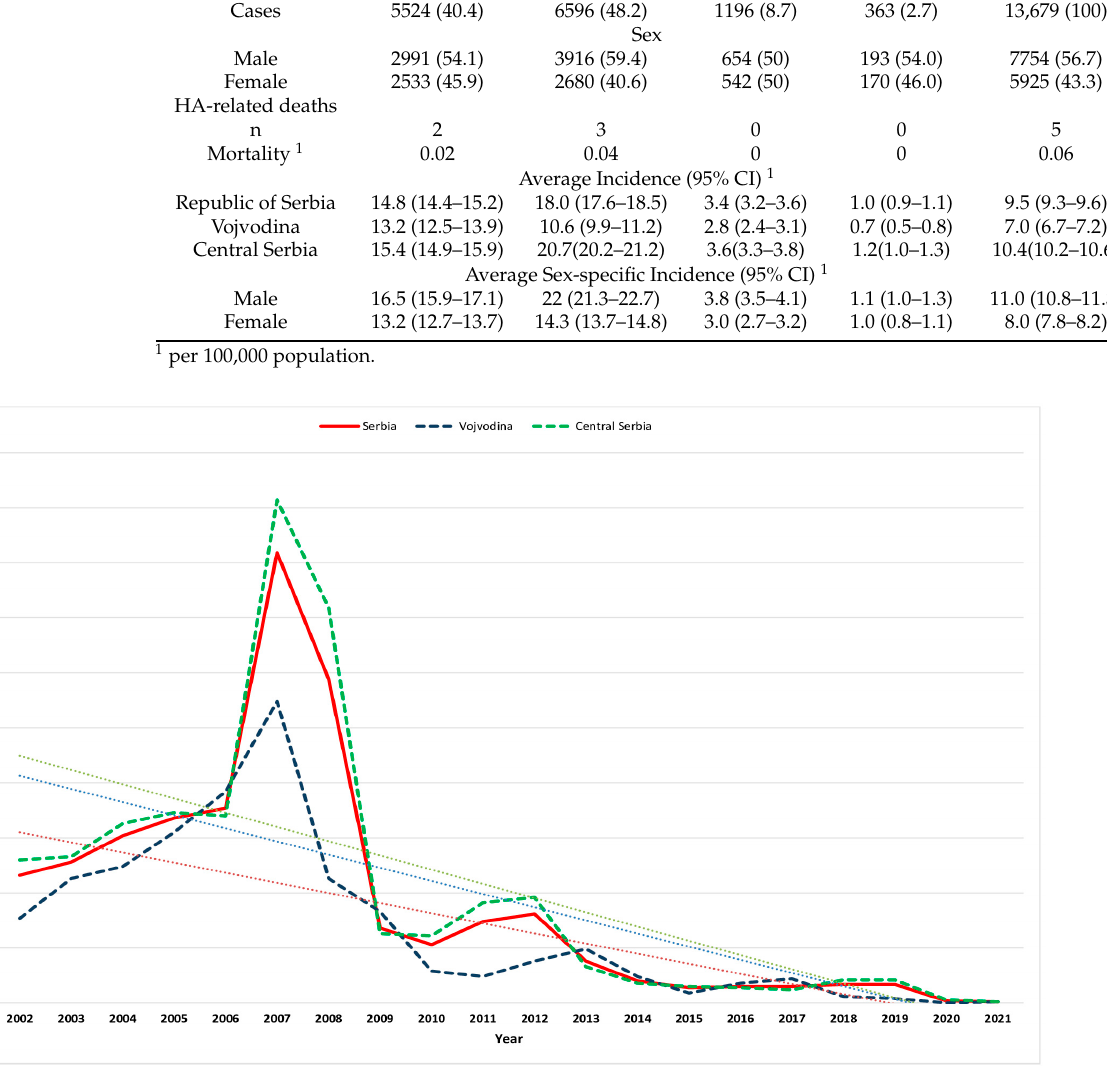
Figure 1. Crude incidence of hepatitis A per 100,000 population in Vojvodina, central Serbia, and Serbia (blue, green, and red lines, respectively) from 2002 to 2021. The corresponding trendlines are also